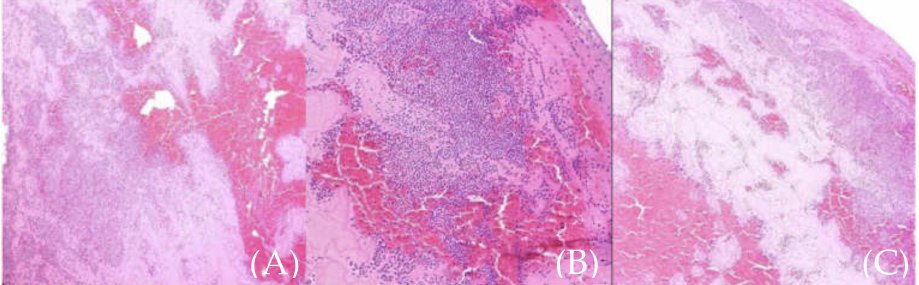
Figure 8. ( A – C ) (different sections of the same sample). Microscopic aspect of the thrombus (fibrin and white and red blood